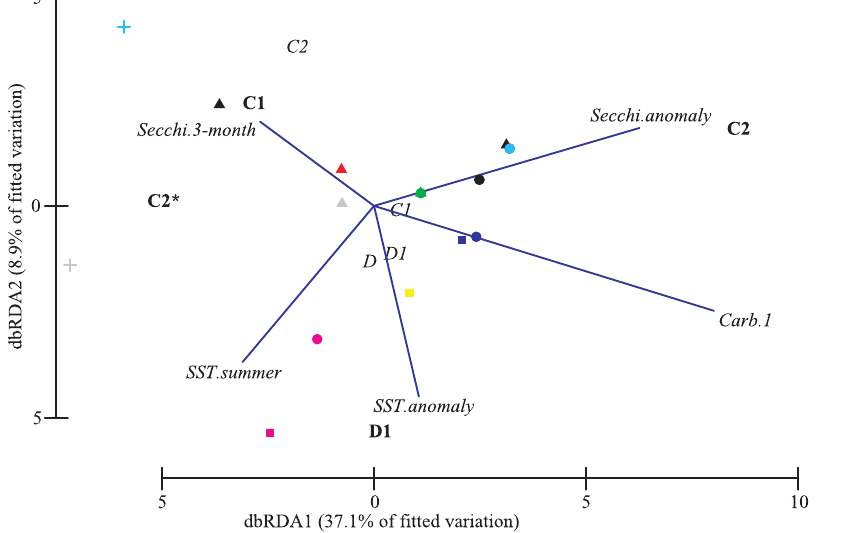
Figure 7. dbRDA ordination for the fitted model of Symbiodinium communities associated with the hard coral Acroporamillepora and N environmental parameters for different years of sampling at Trunk Reef and the Keppel Islands. Symbols: + Trunk Reef, m North Keppel Halfway Is. Colours: red 2001, green 2002, black 2003, navy blue 2004, light blue 2005, pink 2006, yellow 2008, grey 2009. For Is., & Miall Is., symbiont types, bold indicates a dominant type and italics are those occurring in background levels.